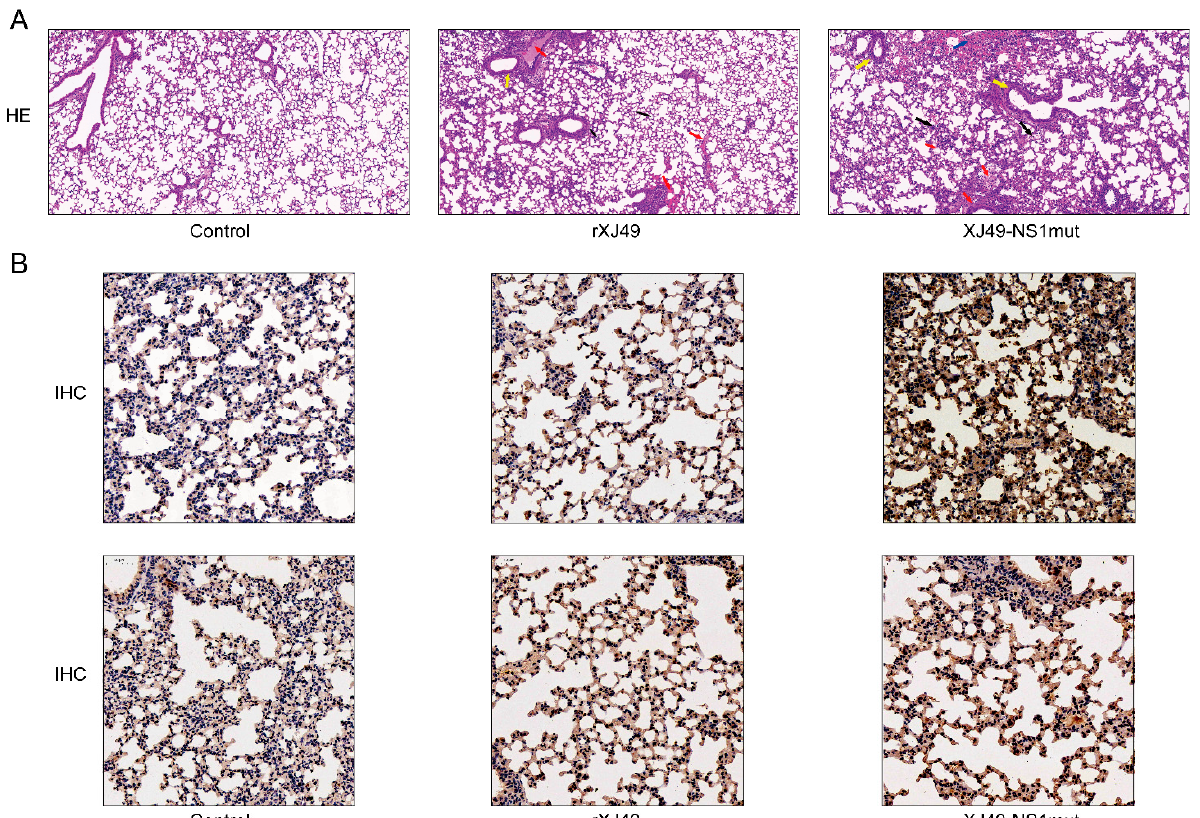
Figure 3. Pathological changes in the lungs of inoculated mice. C57BL/6N mice were infected intranasally with WT rXJ49 or rXJ49-NS1mut at a dose of 80,000 PFU. H&E (×100) and IHC (×50) analysis were performed on section of lung harvested from mice at 6 dpi. Solid arrows indicate inflammatory cell infiltration. ( A ) H&E-stained sections of lungs from mice infected with mock or the indicated viruses. The black arrows indicate large numbers of lymphocytes, neutrophils, and macrophages in the tissue. Yellow arrows indicate inflammatory cells infiltrating around local blood vessels to form a ring or vascular cuff. Red arrows indicate a small amount of bronchial epithelial cell necrosis and nuclear fragmentation locally. The blue arrow indicates local bleeding. ( B , upper row) IAV HA protein-specific staining of lung sections. ( B , lower row) IFN- β -specific staining of lung sections.